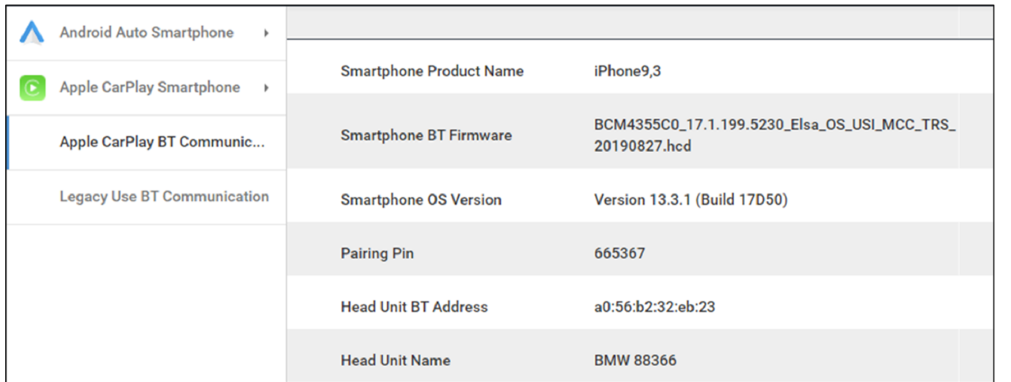
Figure 10. Results of analyzing the Internal Storage of Android Smartphone.